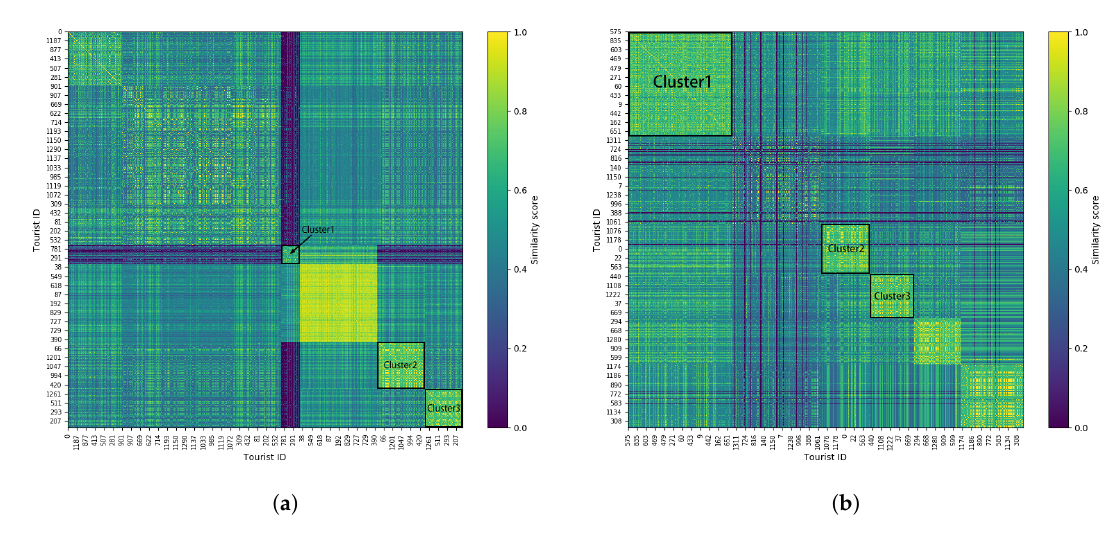
Figure 6. Travel behavior patterns of distinct tourist groups in terms of ( a ) discrete sequence and ( b ) consecutive sequence based motifs. Note that each value in the matrix indicates the similarity between a pair of users based on their topological, temporal and semantic travel motifs. According to Equation (19), the similarity matrix is symmetric, and each row (column) stands for a user’s similarity vector. Yellow color denotes high similarity, while dark blue denotes low similarity. For the sake of readability, user ID labels are annotated by skipping every 30 users. There are several noticeable clusters, and for illustration, 12 users in six distinct clusters derived from discrete and consecutive sequences are randomly selected as samples to analyze and understand the underlying travel behavior patterns